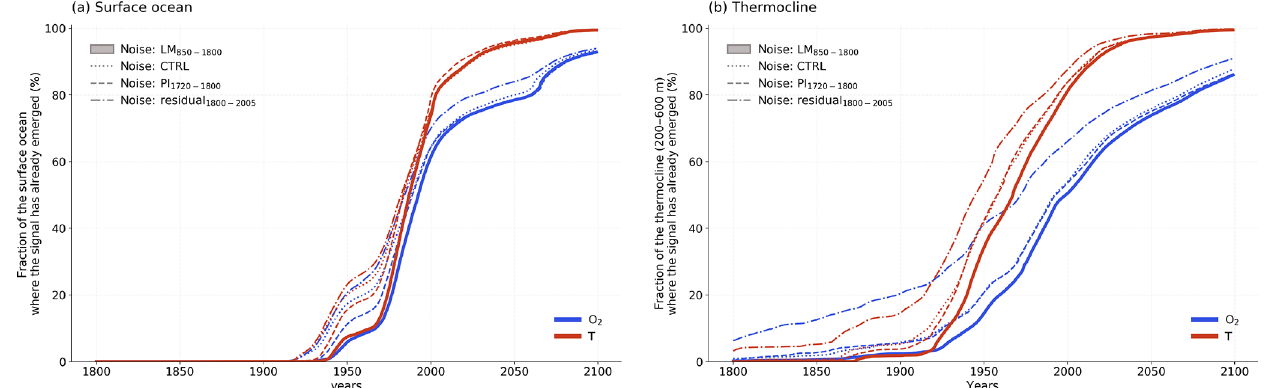
Figure 11. Fraction of the (a) surface ocean and (b) thermocline (200–600m) where the signal has already emerged in oxygen (blue) and temperature (red) for different definitions of the background noise: (i) naturally forced variability during the last millennium (850–1800CE, LM; solid), (ii) internal variability (CTRL; dotted), (iii) naturally forced variability during the pre-industrial period (1720–1800CE, PI; dashed), (iv) residual variability using a low-pass filter (cut-off period of 40 years, residual; dashed dotted).